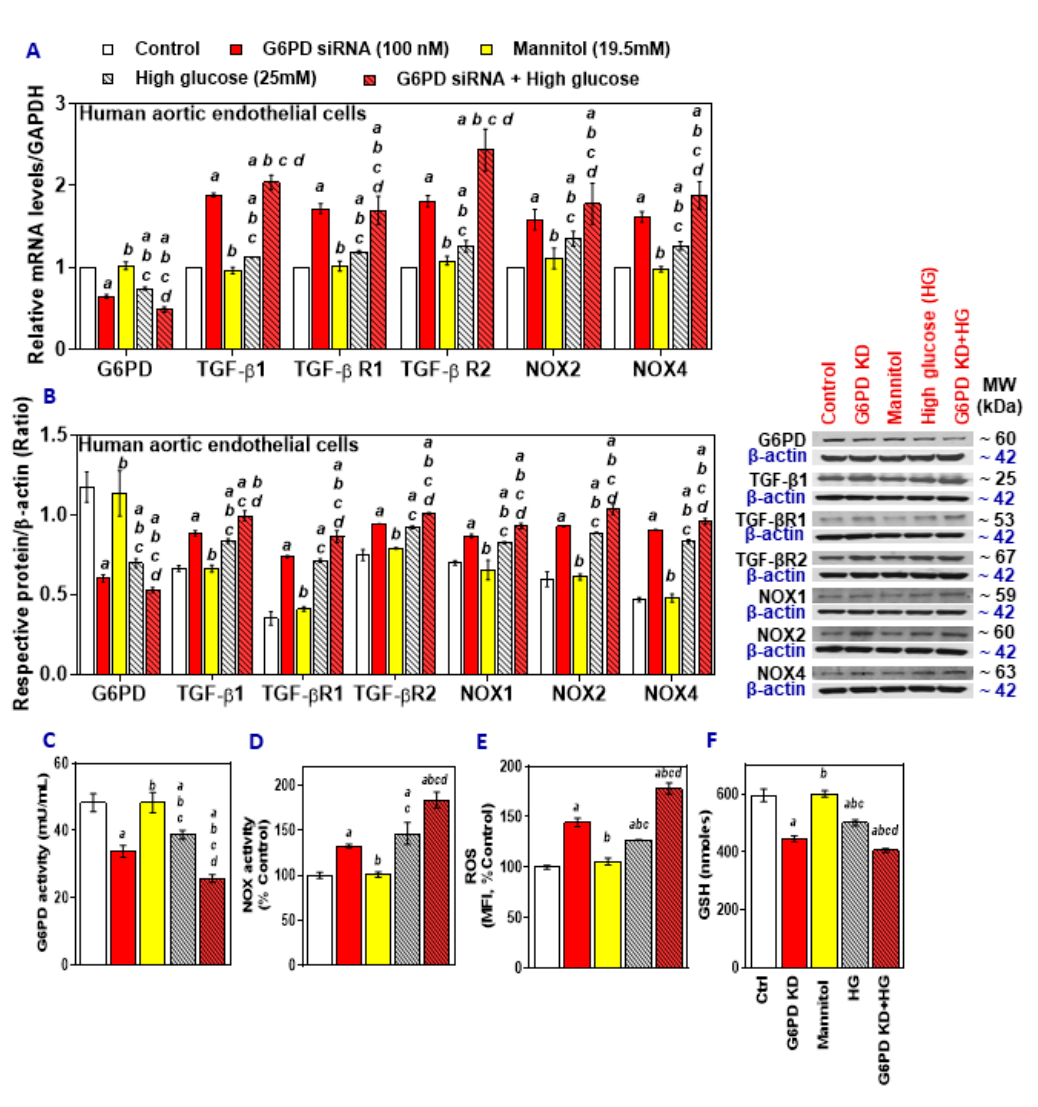
Figure 1. The effect of treatment with high glucose on Glucose-6-phosphate dehydrogenase (G6PD), TGF- β 1, TGF- β 1 receptors, and NADPH oxidases (NOX) in G6PD-normal and G6PD-deficient human aortic endothelial cells (HAEC). ( A ) RT-qPCR was performed to assess the level of target genes as indicated. ( B ) Representative Western blot analysis (G6PD, TGF- β 1, TGF- β R1, TGF- β R2, NOX2, and NOX4) performed on total protein. The left panel represents the semi-quantitative analysis of the ratio of protein abundance to β -actin. ( C ) G6PD activity. ( D ) NADPH oxidase activity. ( E ) reactive oxygen species (ROS) and ( F ) glutathione (GSH) content. Results are mean ± SEM ( n = 3–6). Significance at p < 0.05: a, compared with control; b, compared with G6PD siRNA; c, compared with mannitol; d, compared with high glucose.